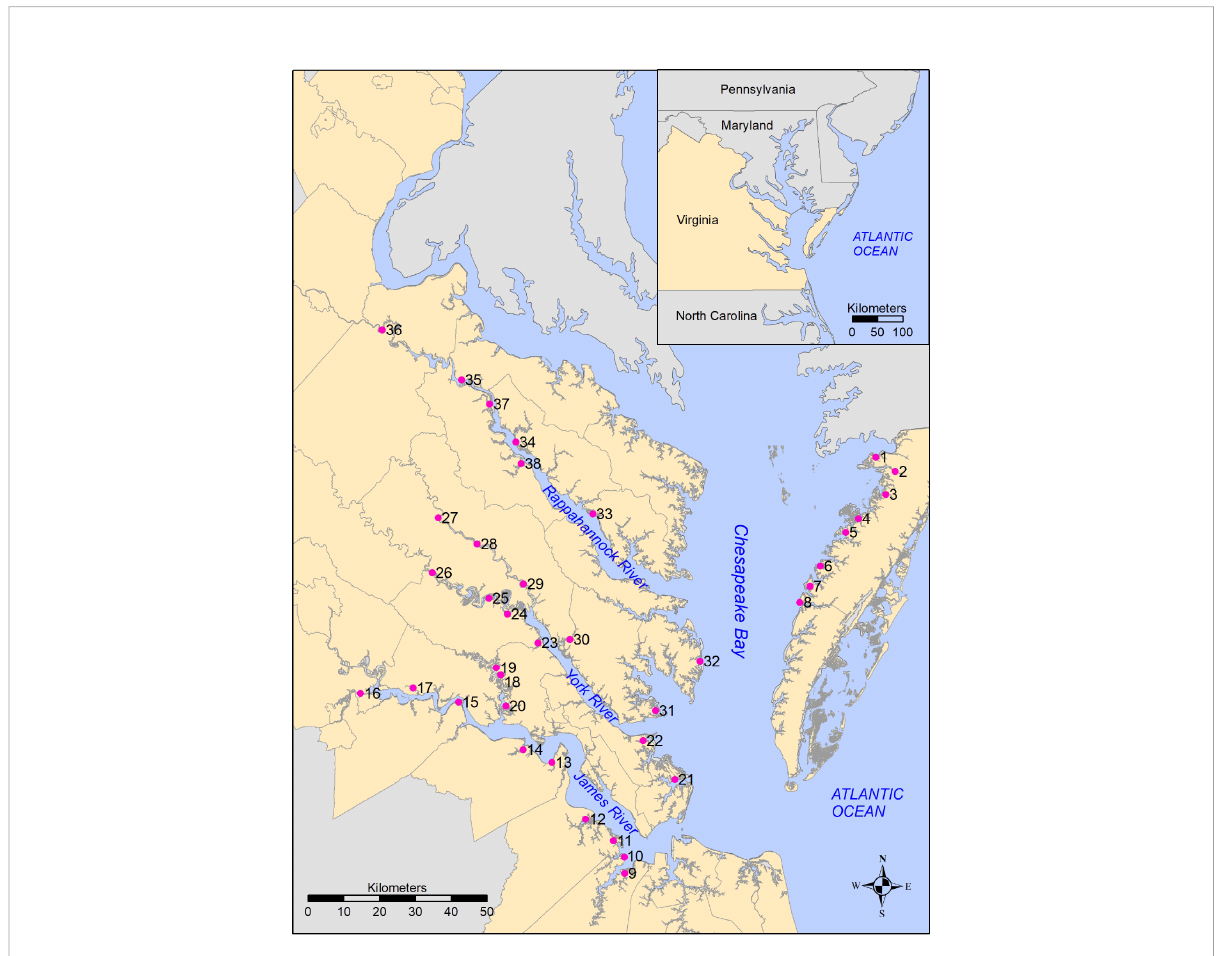
FIGURE 1 Reconstructed locations of marshes (sampling sites) in Edmonds et al. (1990), with inset showing relationship of study area to the Mid-Atlantic coast,